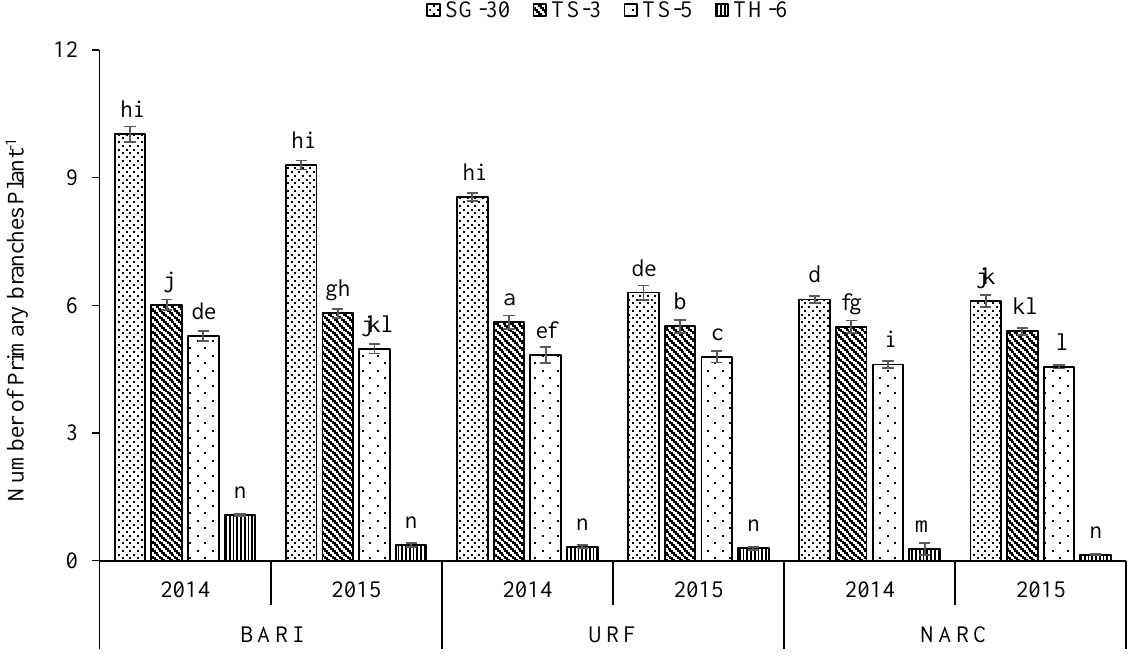
Figure 3. Number of primary branches plant − 1 of four sesame cultivars at three locations during 2014 and 2015 (pooled over micronutrients). The bars indicates standard error ( ± SE) of mean (n = 3). All means are significantly different at p ≤ 0.05.